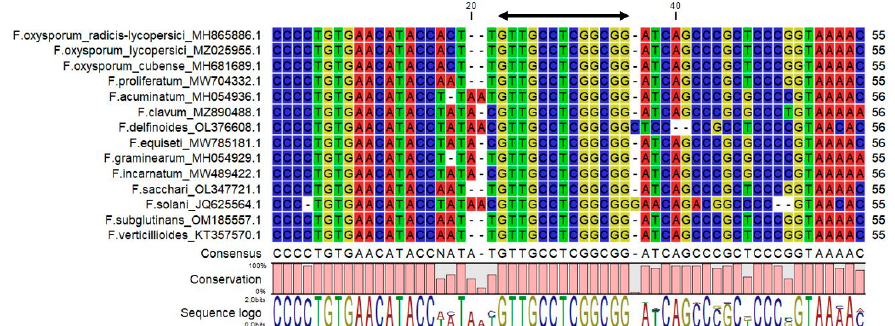
Figure 1. Multiple alignment of a partial sequence of the ribosomal internal transcribed spacer (ITS) region of nuclear rDNA of Fusarium species and respective GenBank accession numbers. The location of the probe is indicated with the arrow and corresponds to the position 80 bp from the complete sequence of Fusarium oxyporum f. sp. radicis-lycopersici (accession number MH865886.1).